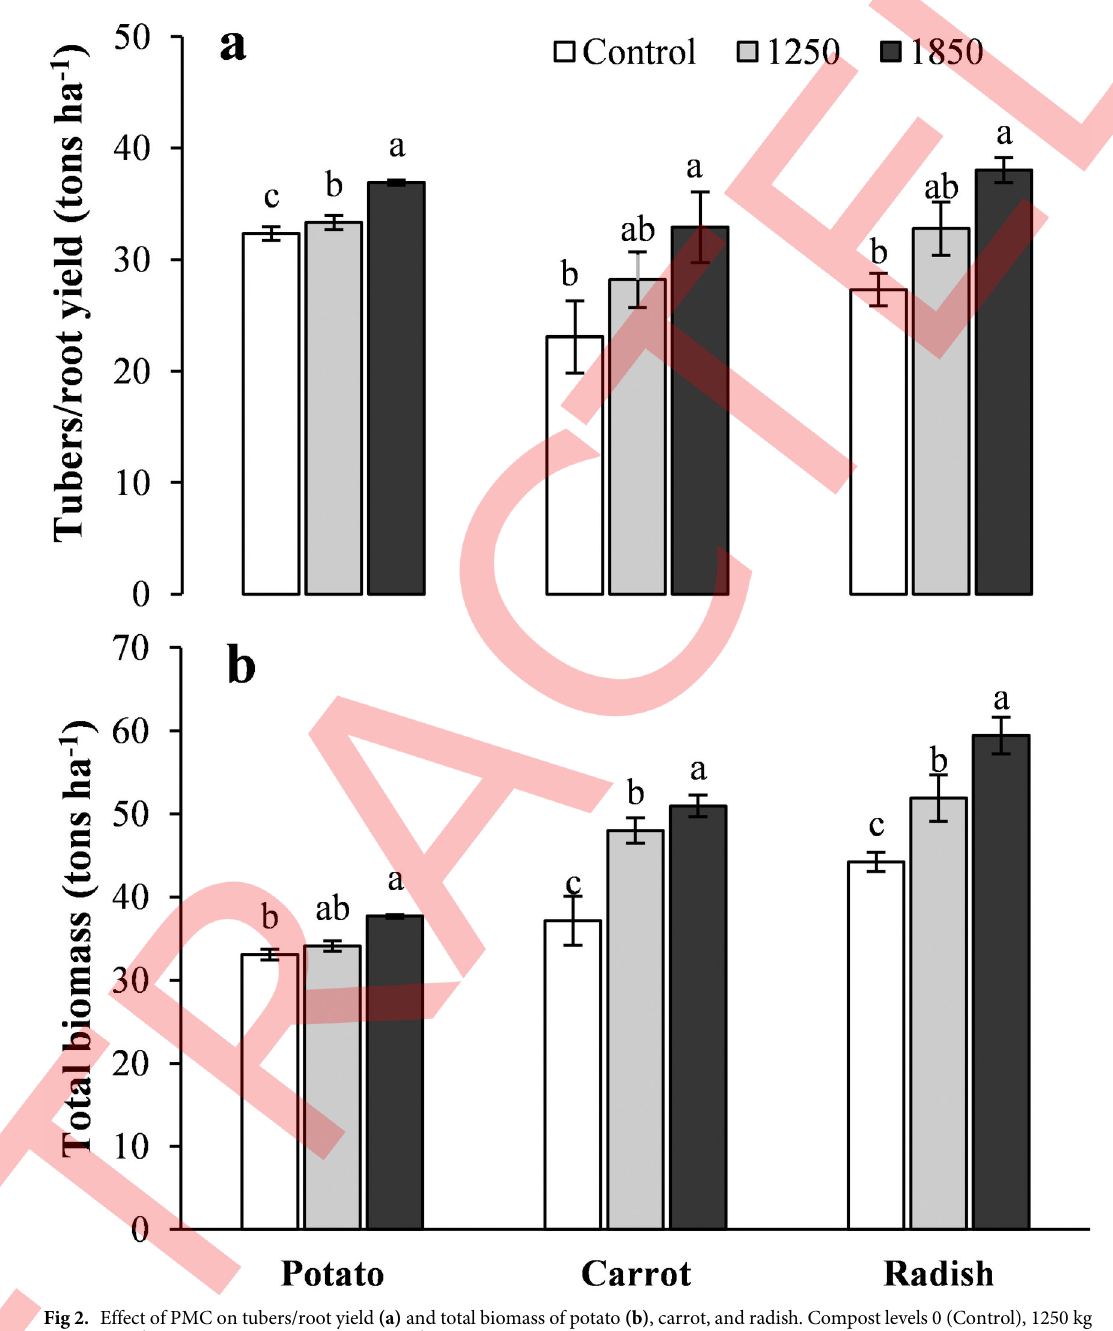
Fig 2. Effect of PMC on tubers/root yield (a) and total biomass of potato (b) , carrot, and radish. Compost levels 0 (Control), 1250 kg compost ha -1 (PMC1) and 1850 kg compost ha -1 (PMC2). The column shows the means of four replications and means sharing similar letter (s) do not differ significantly at P � 0.05 according to the LSD